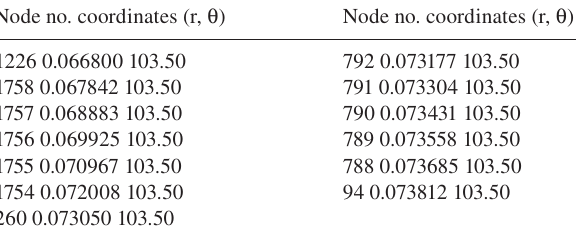
Table 2 Locations of the nodes (r in